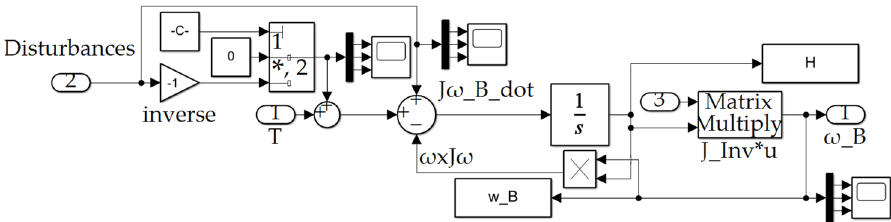
Figure A7. ( a ) Orbital frame calc subsystem depicted in Figure A1; ( b ) Euler angles output subsystem depicted in Figure A1.